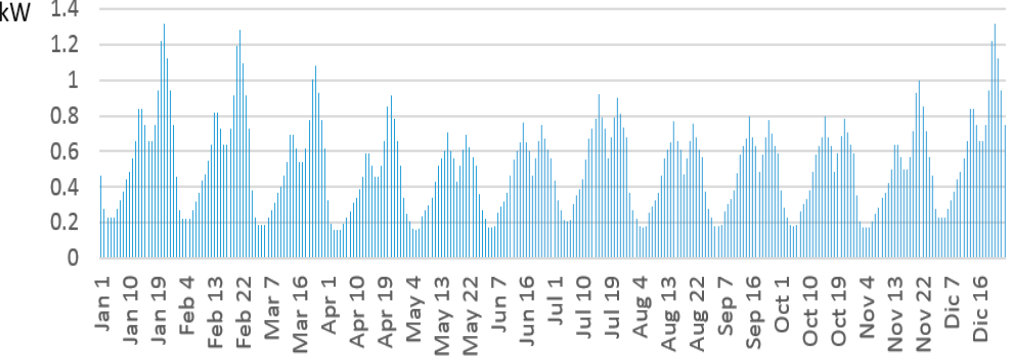
Figure 5. Hourly electrical profile for a standard year.